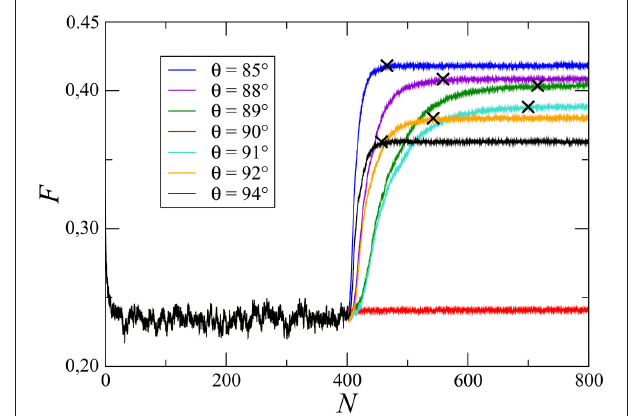
FIGURE 7 | Change in the oil fractional-flow F during the simulation for different values of maximum allowed wetting angle θ . The wettability alteration started at N = 400 pore-volumes. The initialization of the steady-states for different θ values are marked by crosses on the respective plots.